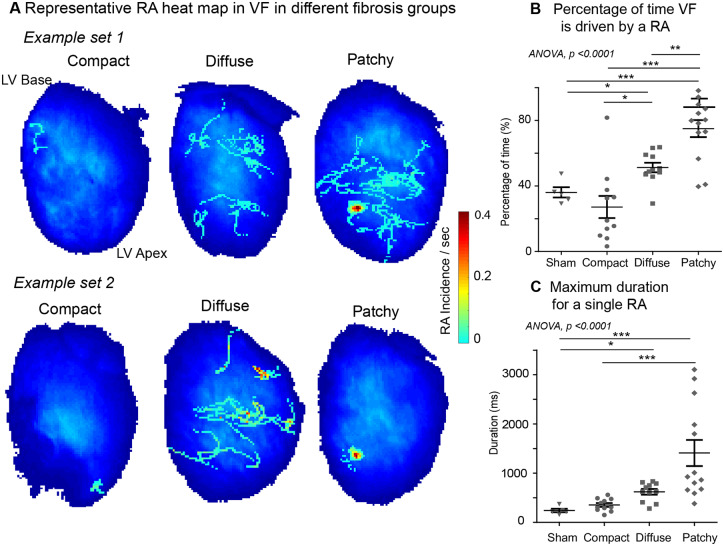
The pattern of fibrosis influences the stability of RAs in fibrillation. (A) Representative RA heat maps for differing fibrosis models; CF, DiF, and PF hearts in VF. (B) Percentage of VF time driven by RAs and (C) maximum duration for a single RA in the PF group is higher in comparison to sham surgery, CF and DiF groups. Data from sham surgery (n = 5), CF (n = 11), DiF (n = 11), and PF (n = 13) hearts. Statistical analysis with ANOVA, post hoc Bonferroni multiple comparisons test, *P < 0.05, **P < 0.01, ***P < 0.001.